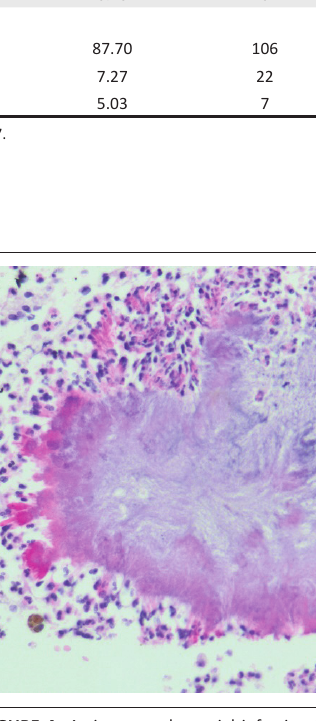
FIGURE 4: Actinomyces bacterial infection in an endometrial sample (original magnification ×400) from a 57-year-old female who presented with postmenopausal bleeding. The bacteria are seen as the large clumped mass of basophilic filamentous structures.